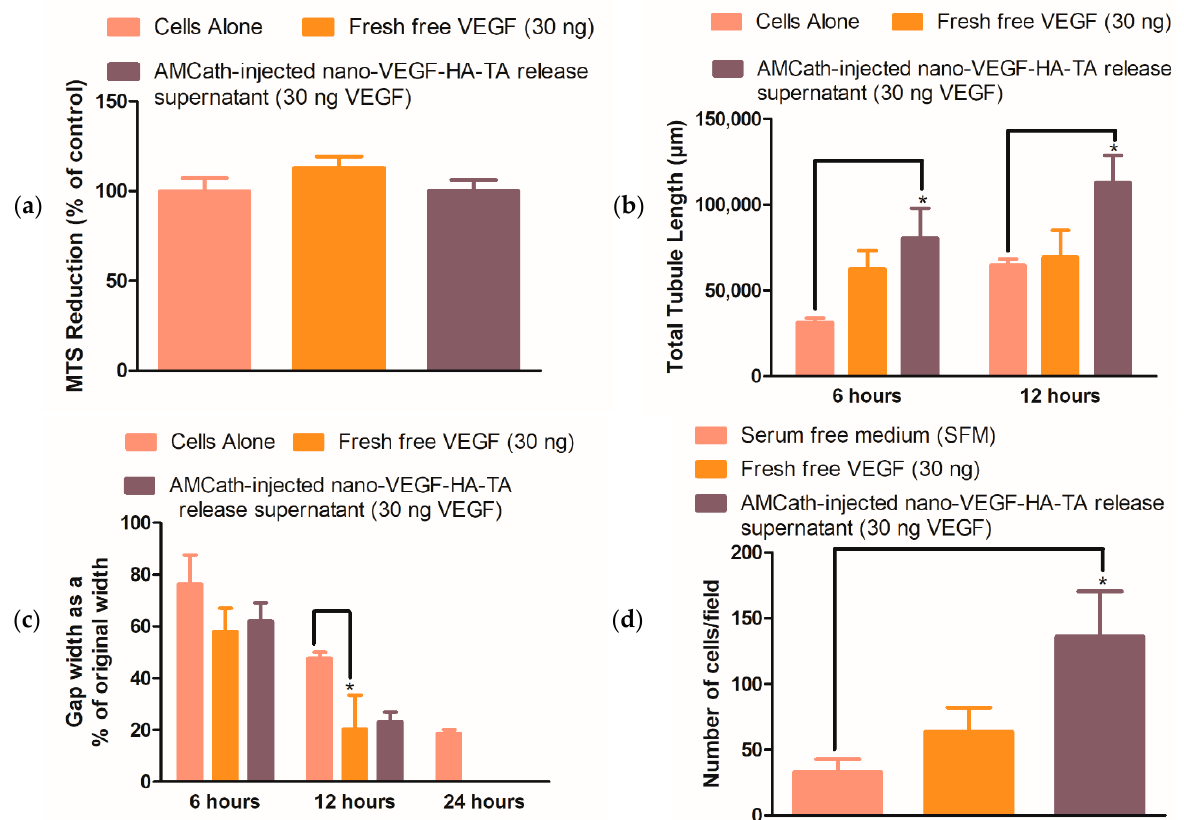
Figure 7. ( a ) Metabolic activity of human umbilical vein endothelial cells (HUVECs) exposed to release supernatant from AMCath-injected nano-VEGF-HA-TA, compared to cells fed with normal media without VEGF, or media containing 30 ng fresh free VEGF. ( b ) Quantified total tubule length on a Matrigel ® assay produced by 42-day pooled release supernatant from nano-VEGF-HA-TA formulations formed via injection through AMCath compared to the tubule length produced by untreated cells or those exposed to a similar dose (30 ng) of fresh free VEGF. ( c ) Quantification of remaining gap width on a scratch assay, where zero indicates complete gap closure. HUVECs were exposed to nano-VEGF-HA-TA release super- natant or fresh free VEGF, each containing 30 ng VEGF, and cells not treated with VEGF were used as a control. ( d ) Cell migration as determined by number of calcein stained cells per field on a Transwell ® migration assay. Quantification of the migration of HUVECs in medium without VEGF (cells alone in serum-free medium) is compared to that achieved by HUVECs treated with 30 ng fresh free VEGF or pooled release medium from AMCath formed nano-VEGF-HA-TA also containing 30 ng VEGF. * p < 0.05. ( n = 3 technical replicates). 4. Discussion Herein, a number of key studies for the translation of a novel nano-in-gel delivery system for the targeted delivery of VEGF were conducted. A CAM study was performed as the initial in vivo interrogation of the nano-VEGF-HA-TA formulation. The first output from the CAM study was the observed lack of toxicity of the delivery system. It has pre- viously been suggested that a mortality rate of 50% is to be expected with the CAM model; a 40% mortality rate was observed in all groups here, slightly better than that cited in the literature [37]. All chick embryos displayed common anatomical features; eyes, legs and wings were visible in all cases, further signaling a lack of toxicity. While this would need further investigation in other animal models, the absence of evidence of toxicity at this early stage is promising. Administration of VEGF without other growth factors has been reported to produce immature, hyperpermeable blood vessels, although this finding was related primarily to the delivery of nucleic acids encoding for VEGF [38]. Increased vessel permeability has previously been observed in CAM assays by Dunn et al. and is evidenced by the presence of hyperemic foci, essentially specks of blood in the space between vessels [36]. No hyper- emia was evident in the CAM study performed herein, which corroborates evidence in the literature that the controlled delivery of the VEGF protein overcomes this hyperper- meability issue [38]. Having determined the health of the embryos and the integrity of the blood vessels formed, the angiogenic properties of the formulations were examined. Branching of ves- sels is a key process in the development of an interlinked vessel network and is a com- monly reported output of the chick CAM experiment post-treatment with angiogenic fac- tors. In Figure 4, an area of CAM treated with (a) HA-TA alone was compared to that exposed to (b) free VEGF-HA-TA and (c) nano-VEGF-HA-TA. The most branching points and capillary-like structures were visible following treatment with nano-VEGF-HA-TA, and this is quantified in Figure 4d. While free VEGF-HA-TA did not significantly increase the number of branch points compared to HA-TA alone, nano-VEGF-HA-TA did signifi- cantly ( p < 0.05) increase the number of branch points compared to treatment with the HA-